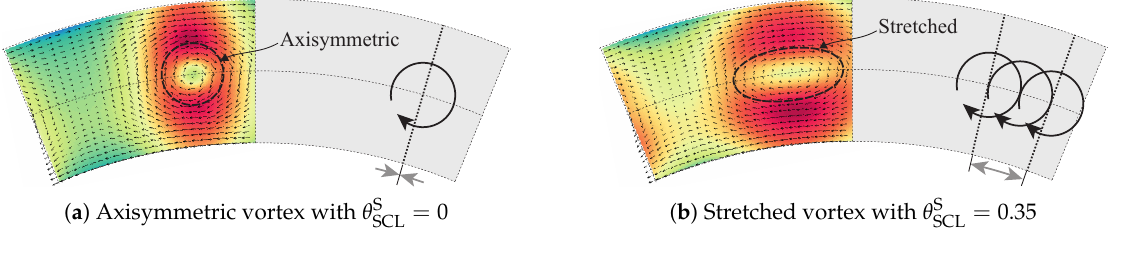
Figure 5. Vortex